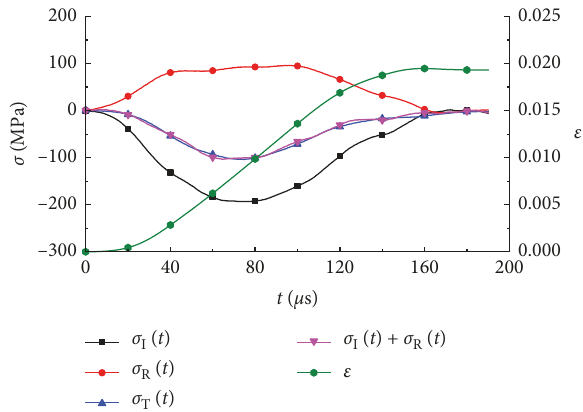
Figure 4: Dynamic stresses and strain in the dynamic uniaxial compressive test.